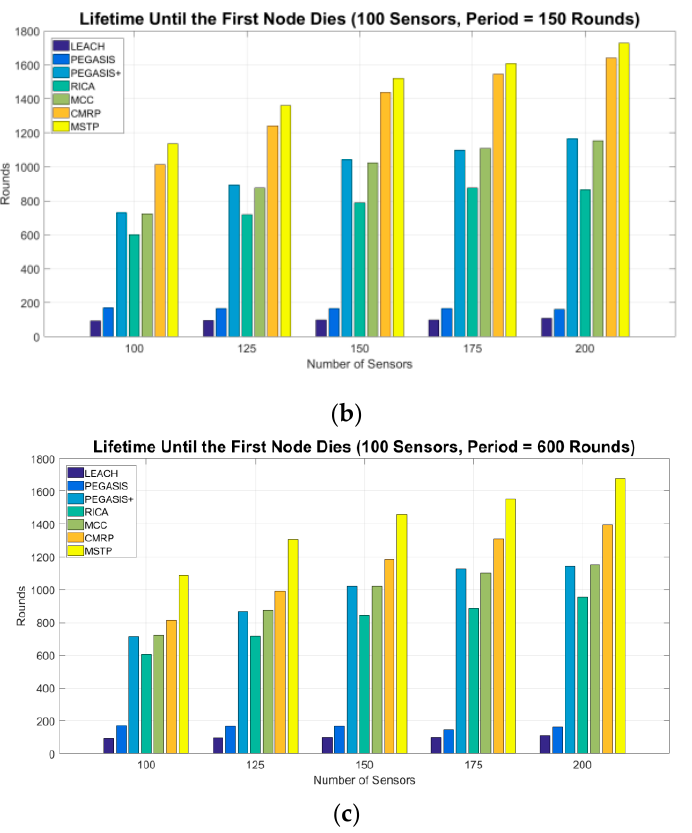
Figure 9. Impact of the sunlight coverage period. ( a ) coverage period is 50 rounds; ( b ) coverage period is 150 rounds; ( c ) coverage period is 600 rounds.